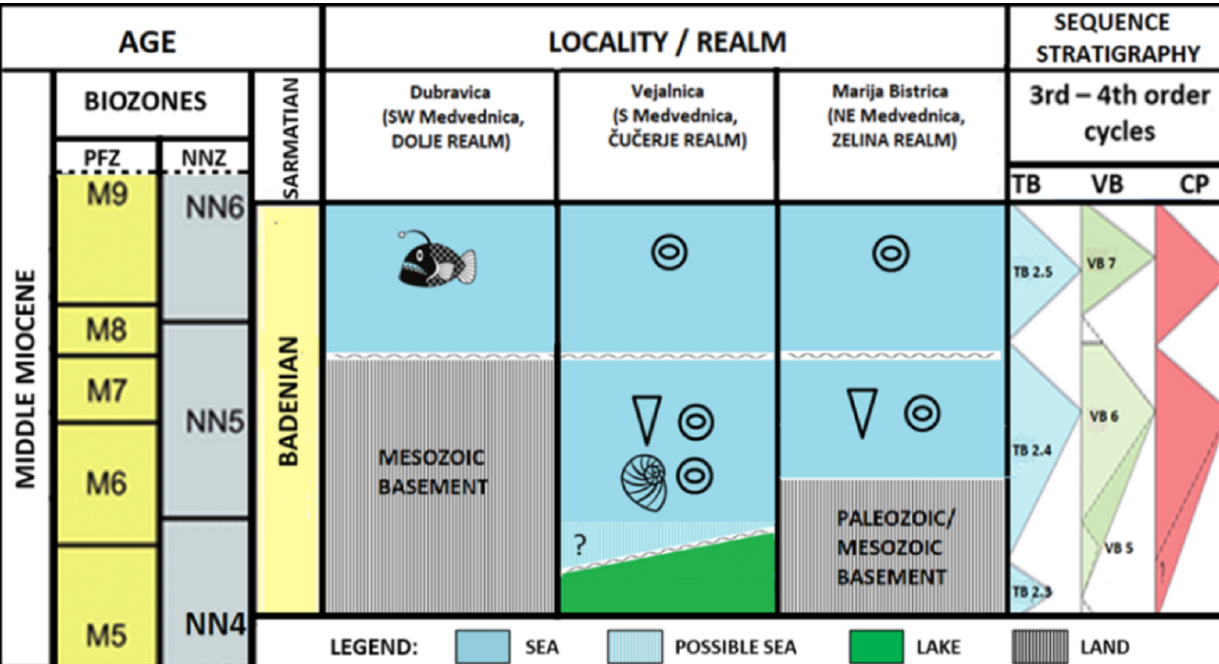
Figure 12. Evidence of three Badenian (Langhian − Serravallian) transgressive ‐ regressive cycles (TB 2.3, TB 2.4 and TB 2.5) at three Miocene localities, representing sedimentary realms in the area of Medvednica Mt. (sensu [114]): Marine transgressions are highlighted with blue color. Lacustrine deposits in the base of the Č u č erje Realm succession are green (after [115] modified). For the bi ‐